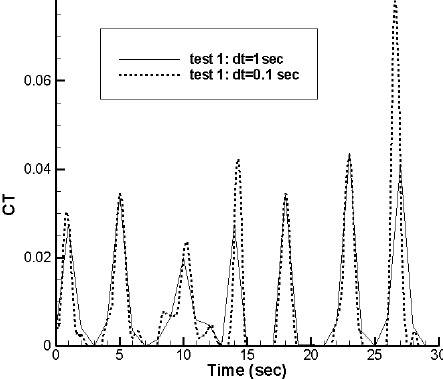
Figure 36. Comparison of the time history of the thrust (C T ) coefficient, numerical experiment #1.